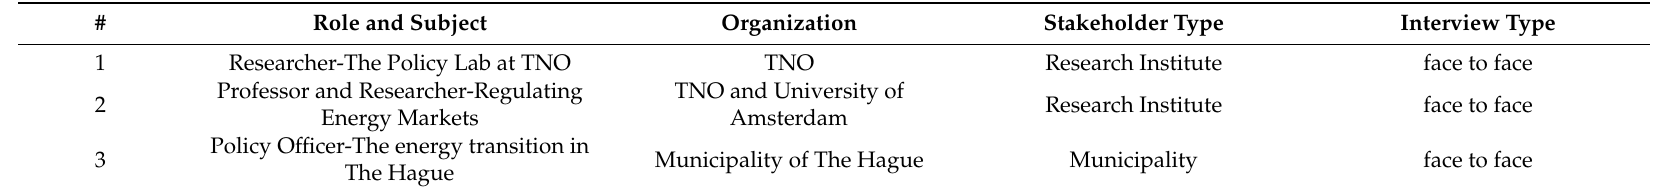
Table A1. Interviews in the context of the pre-problem analysis.